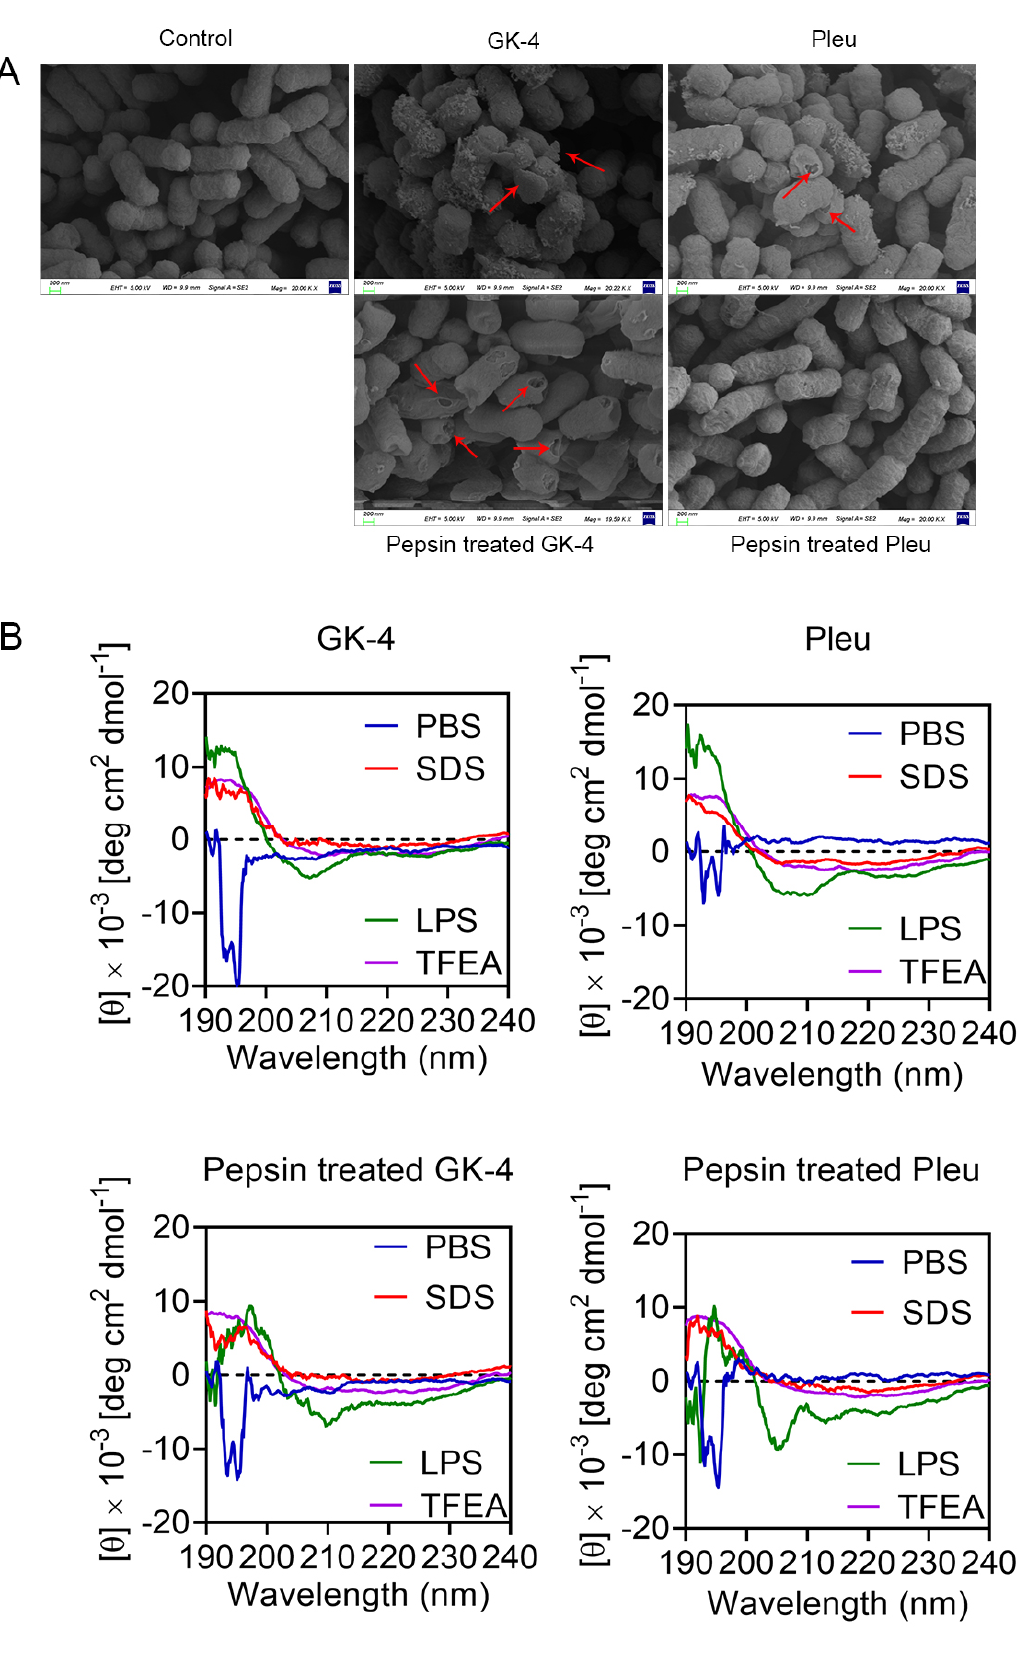
Figure 5. ( A ) SEM images of E. coli B2 exposed to GK-4 and Pleu, or GK-4 and Pleu treated with 10 mg/mL pepsin, and the peptide concentrations were fixed at 20 μ g/mL (10–fold MIC). All pepsin treated peptides were heated at 100 °C for 30 min and centrifuged at 130,00× g for 30 min. Then the